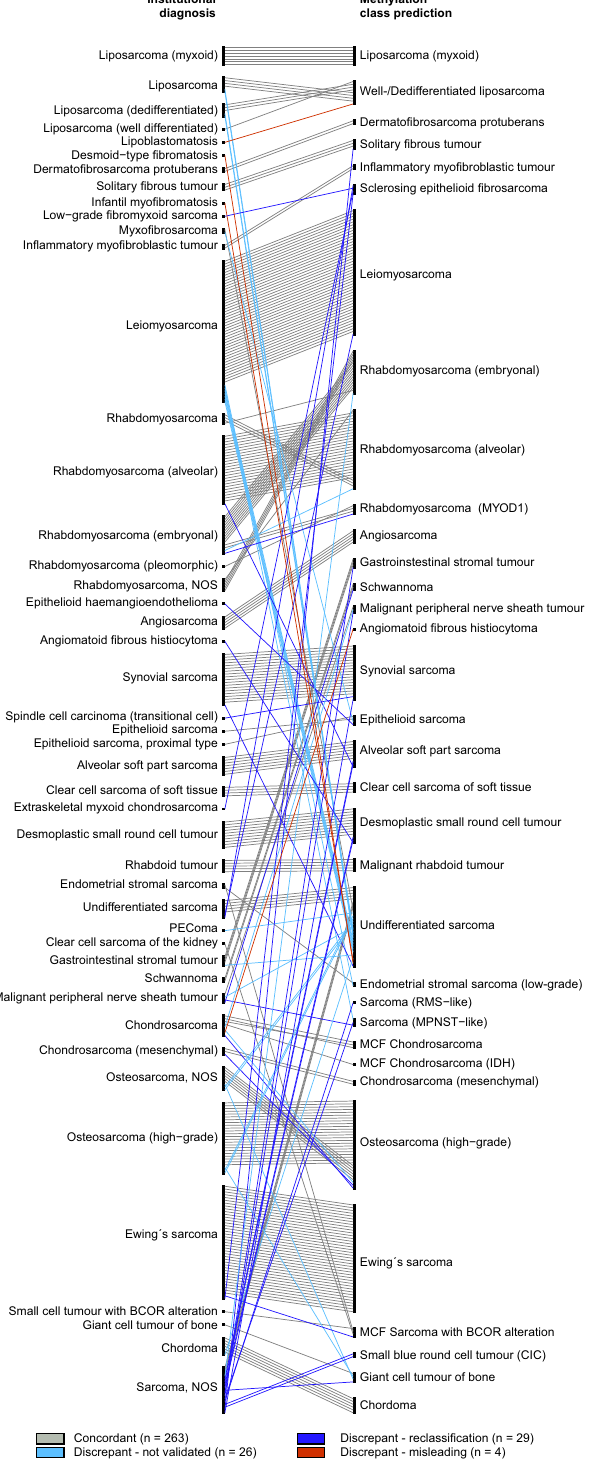
Fig. 4 Comparison of pathological diagnosis and methylation class prediction. Classi fi er validation using sarcoma cases enrolled in the MNP2.0, PTT2.0, INFORM or NCT MASTER trials. Institutional diagnosis (left) and classi fi er prediction (right) of the 322 cases that received a methylation class prediction ≥ 0.9. The institutional diagnosis of 263 cases matched the classi fi er prediction (concordant; grey bars). In 59 cases the classi fi er prediction differed from institutional diagnosis, with 29 cases reclassi fi ed in favour of the methylation class prediction (discrepant — reclassi fi ed; blue bars), 26 cases where molecular validation analysis was inconclusive (discrepant; light blue bars), and four cases with a misleading classi fi er result (discrepant – misleading;